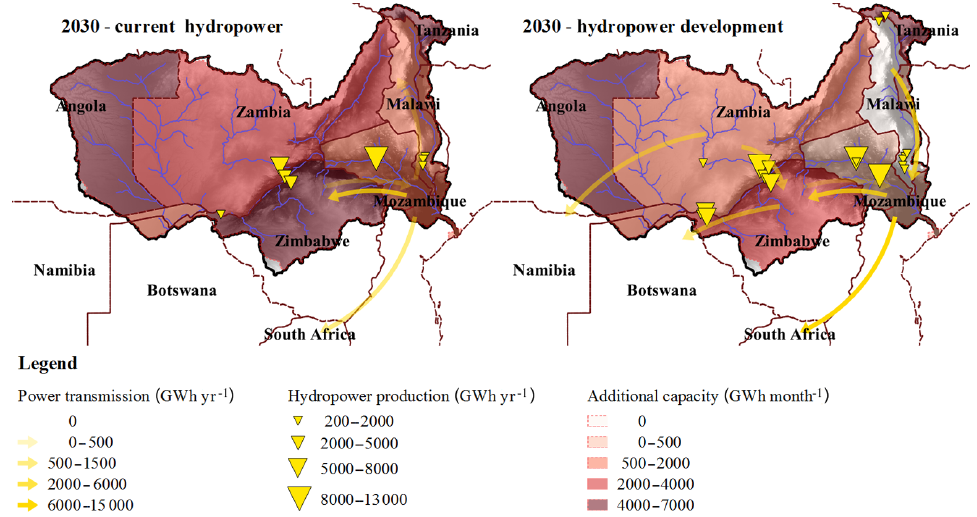
Figure 8. Power transmission, hydropower production, and additional capacity investments before and after implementation of the hy- dropower investment plan. The implementation of the hydropower development plan is found to considerably increase the power exchanges among the SAPP countries and reduce the need to invest in additional power generation capacity.